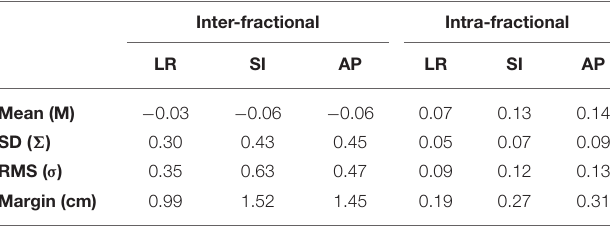
TABLE 1 | Patient characteristics. TABLE 2 | Mean, standard deviation (SD, 6 ), and root mean square (RMS, σ ) of inter- and intra- fractional motion of the prostate for patients treated with 5-fraction stereotactic body radiation